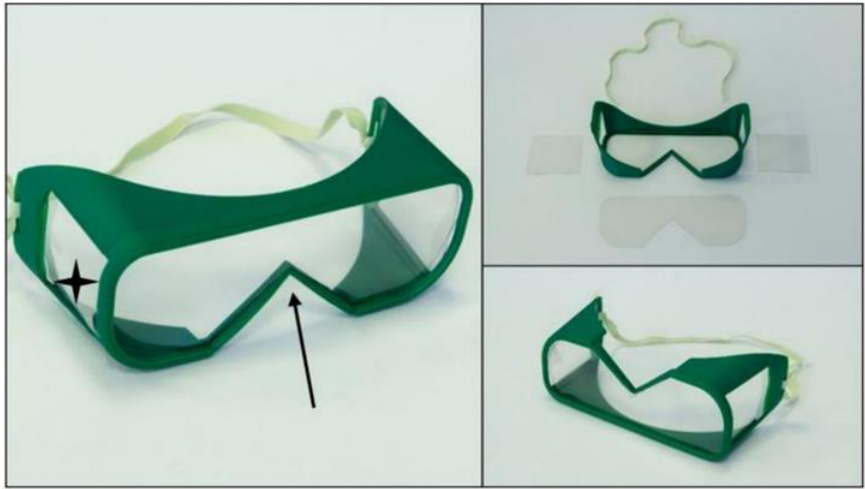
Figure 9. Safety Goggles V2.0. The model improvements are marked: new openings on the side of the model (black stars); the modified part for better fitting with face masks (black arrow).